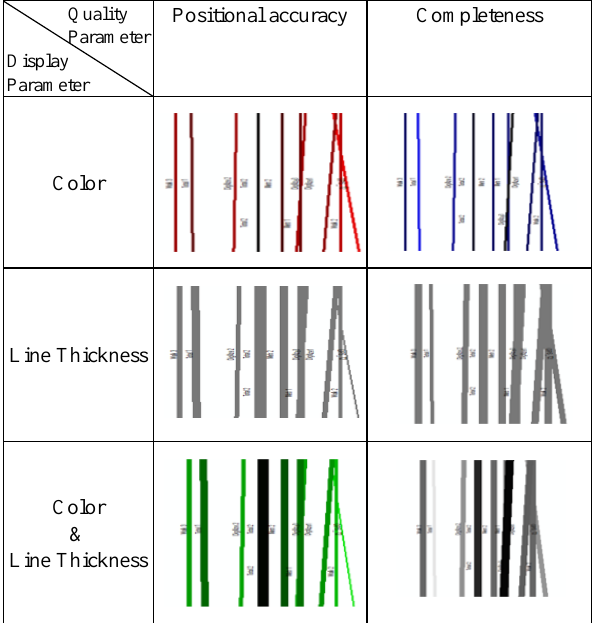
Table 1. Visual representation of spatial quality parameters of the datasets by color, line thickness and both (Karimipour et al.,